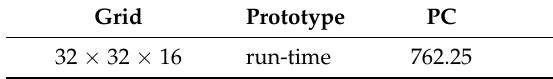
Figure 8. Snapshot of the computation module. Figure 9. Snapshot of the data swap module.